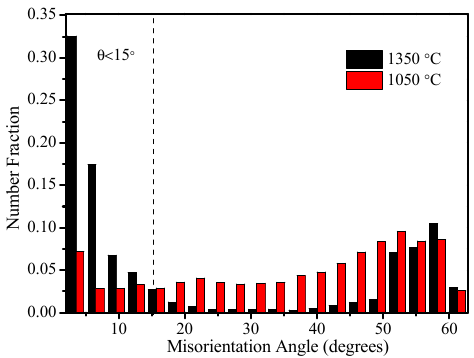
Figure 12. Crystallographic characteristics of the fatigue cracks at peak temperature of 1050 °C. ( a ) Orientation image maps; ( b ) Image quality maps with grain boundary misorientation distribution.